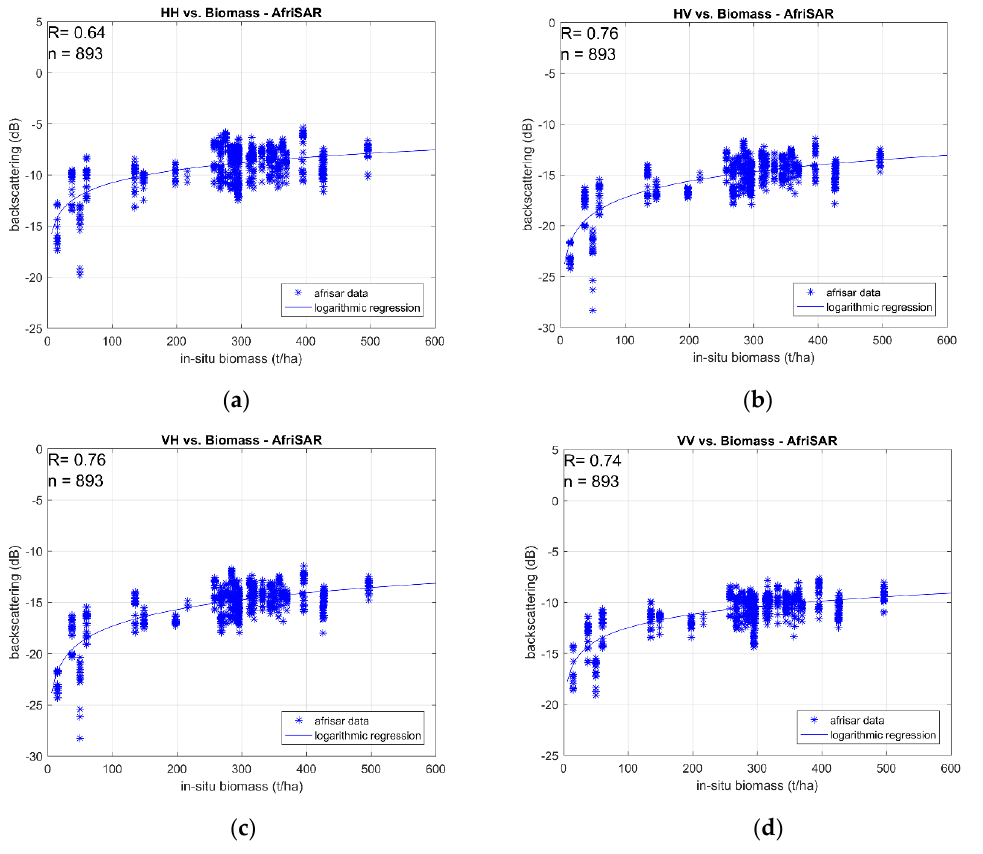
Figure 3. AfriSAR dataset: σ° at P-band vs. Biomass in ( a ) HH polarization, ( b ) HV polarization, ( c ) VH polarization, ( d ) VV polarization